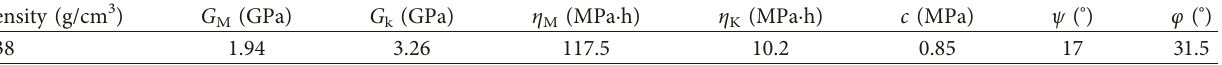
Table 3: Parameters of the coal from Huangling no. 2 coal